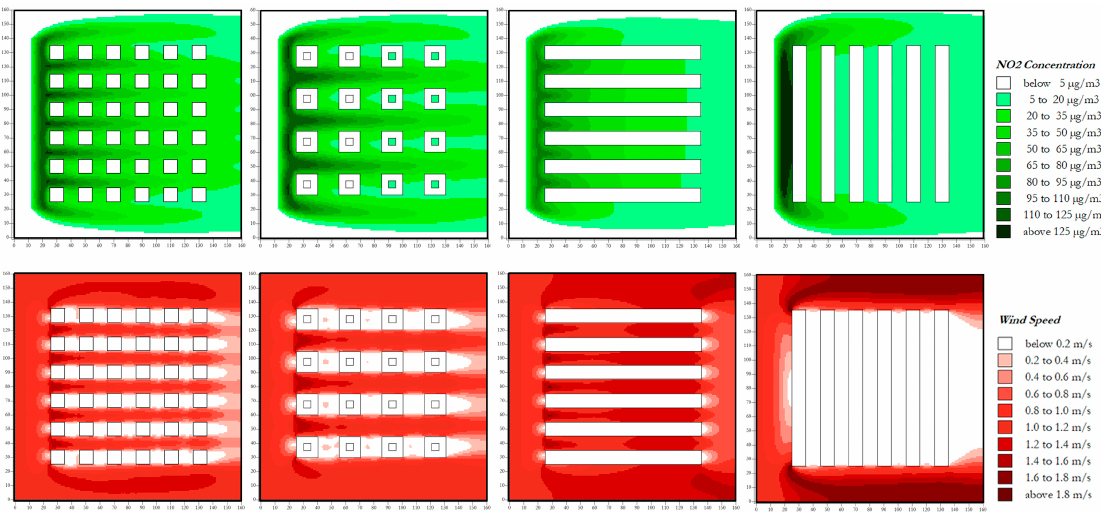
Figure 7. Spatial distribution of NO 2 concentration in the four scenarios at 9